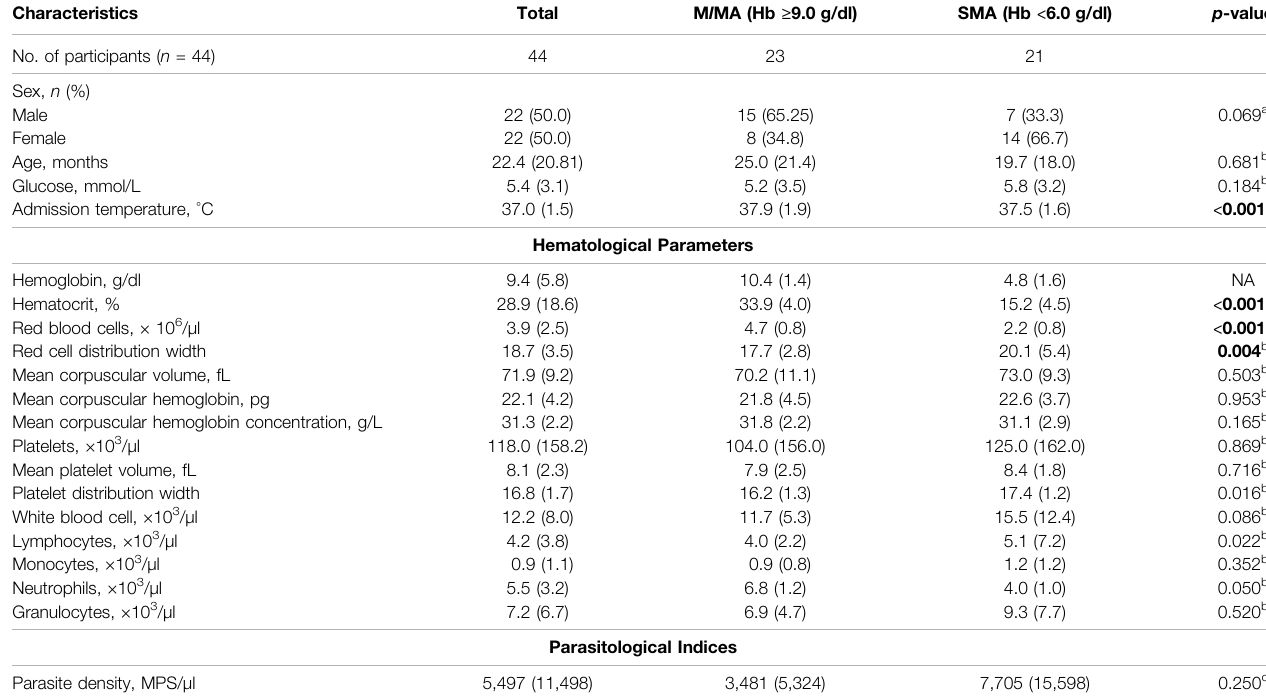
TABLE 1 | Demographic, clinical, and laboratory characteristics of the study